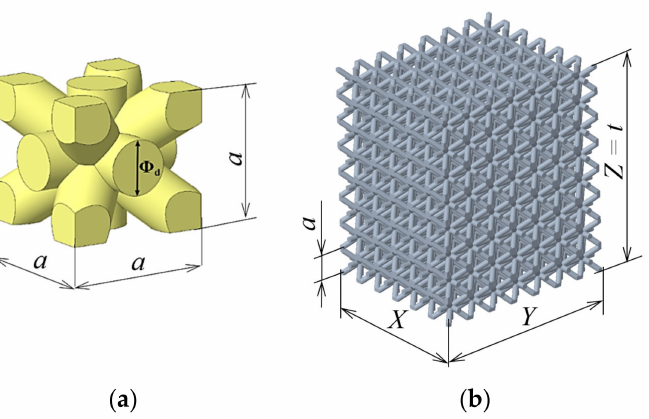
Figure 1. Lattice structure: ( a ) basic body-centered cubic (BCC) cell and ( b ) virtual model of the lattice